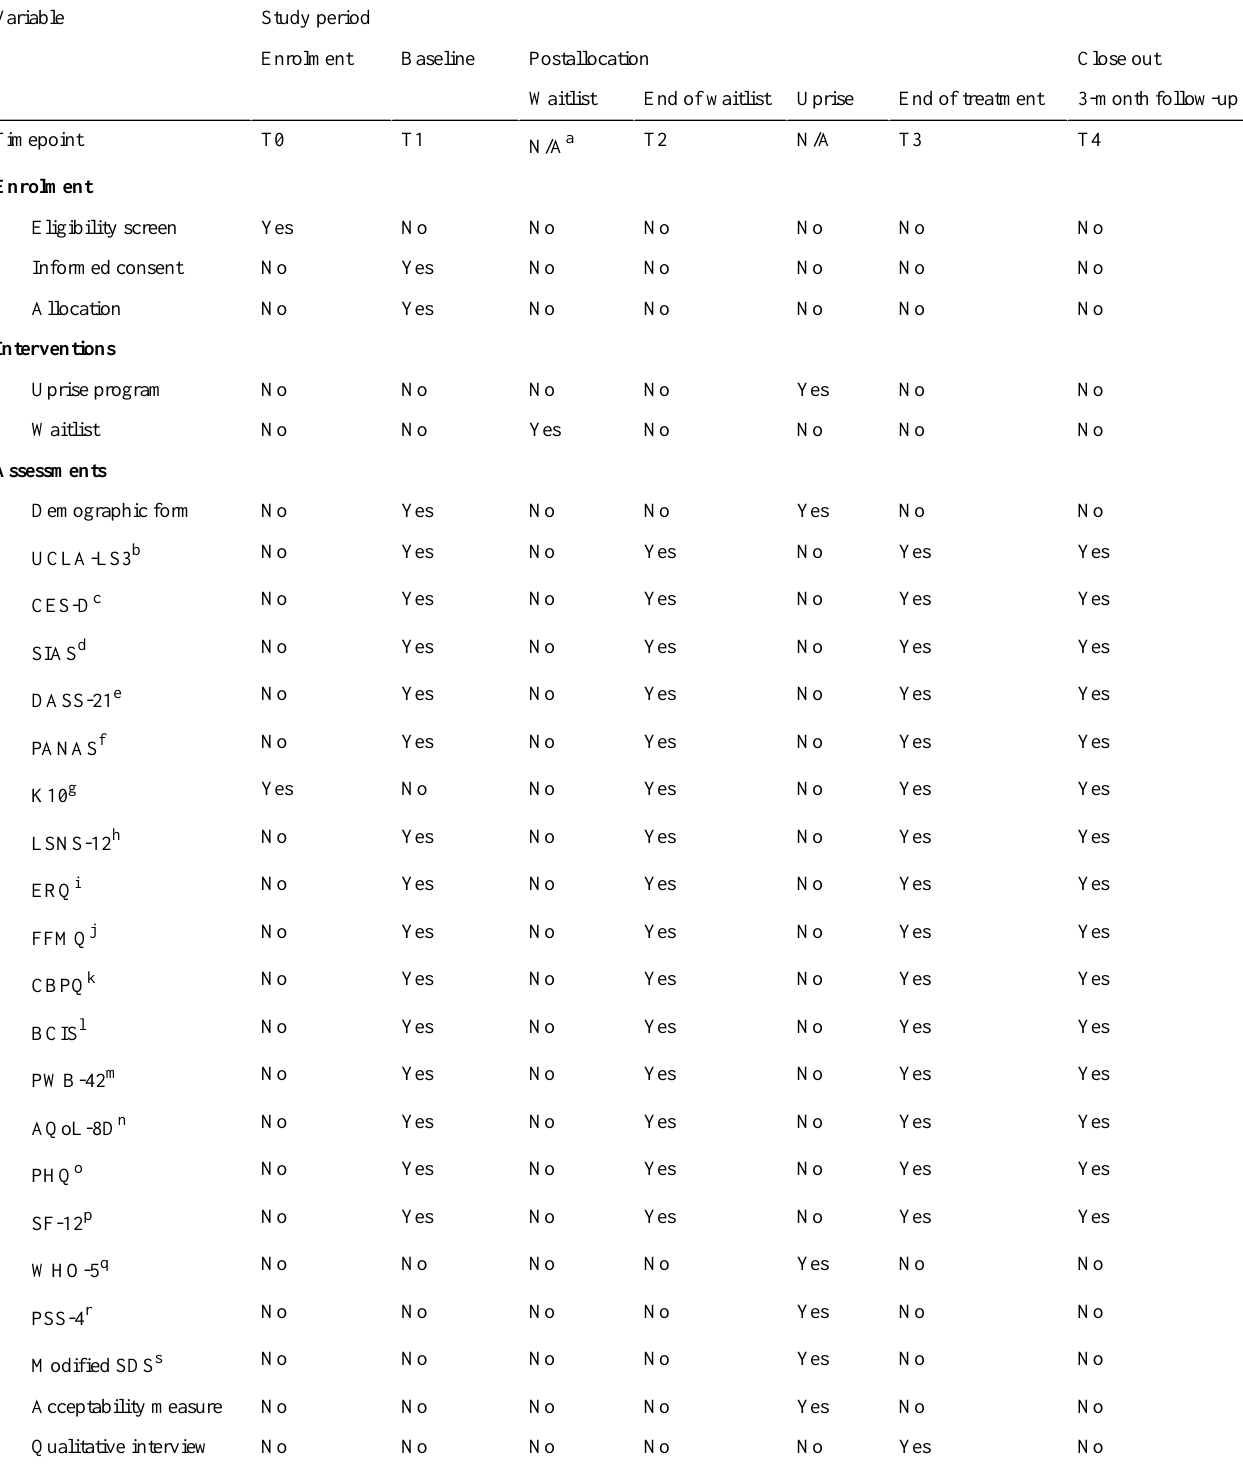
Table 1. SPIRIT schedule of enrolment, interventions, and assessments.